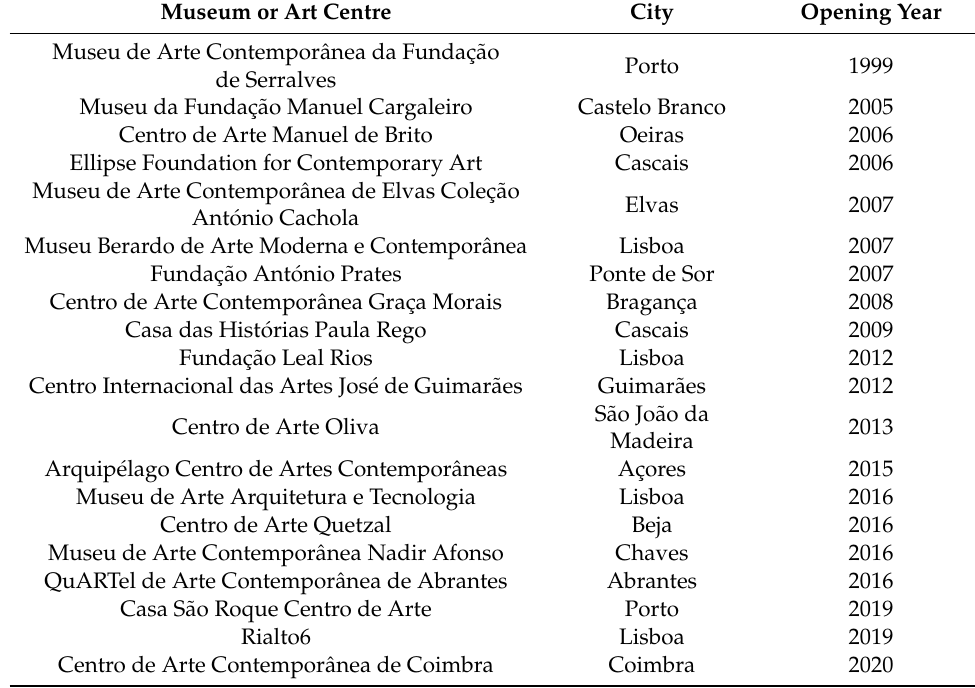
Table 2. The growing number of contemporary art museums and art centres in Portugal in the 21st century.